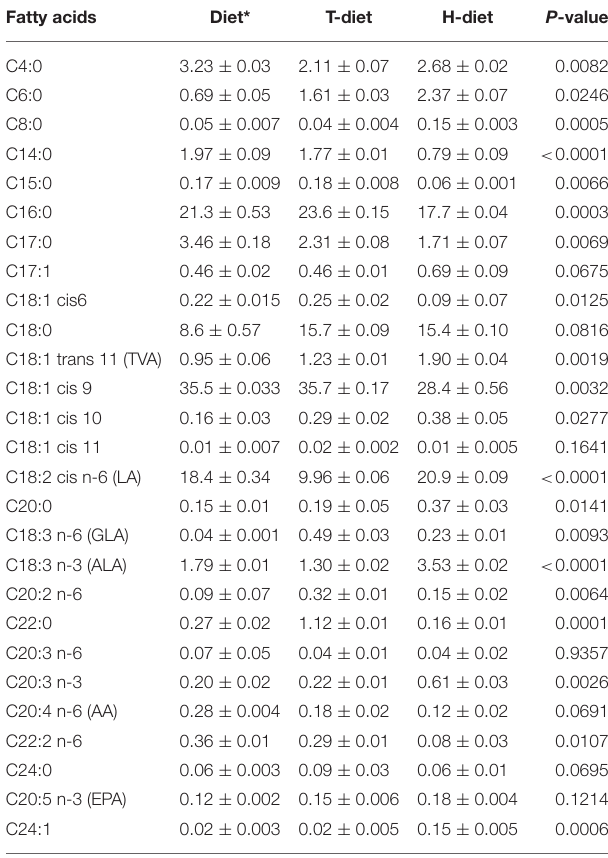
TABLE 1 | Chemical composition (mean and standard deviation) of administered diets. Nutrients (% as feed)